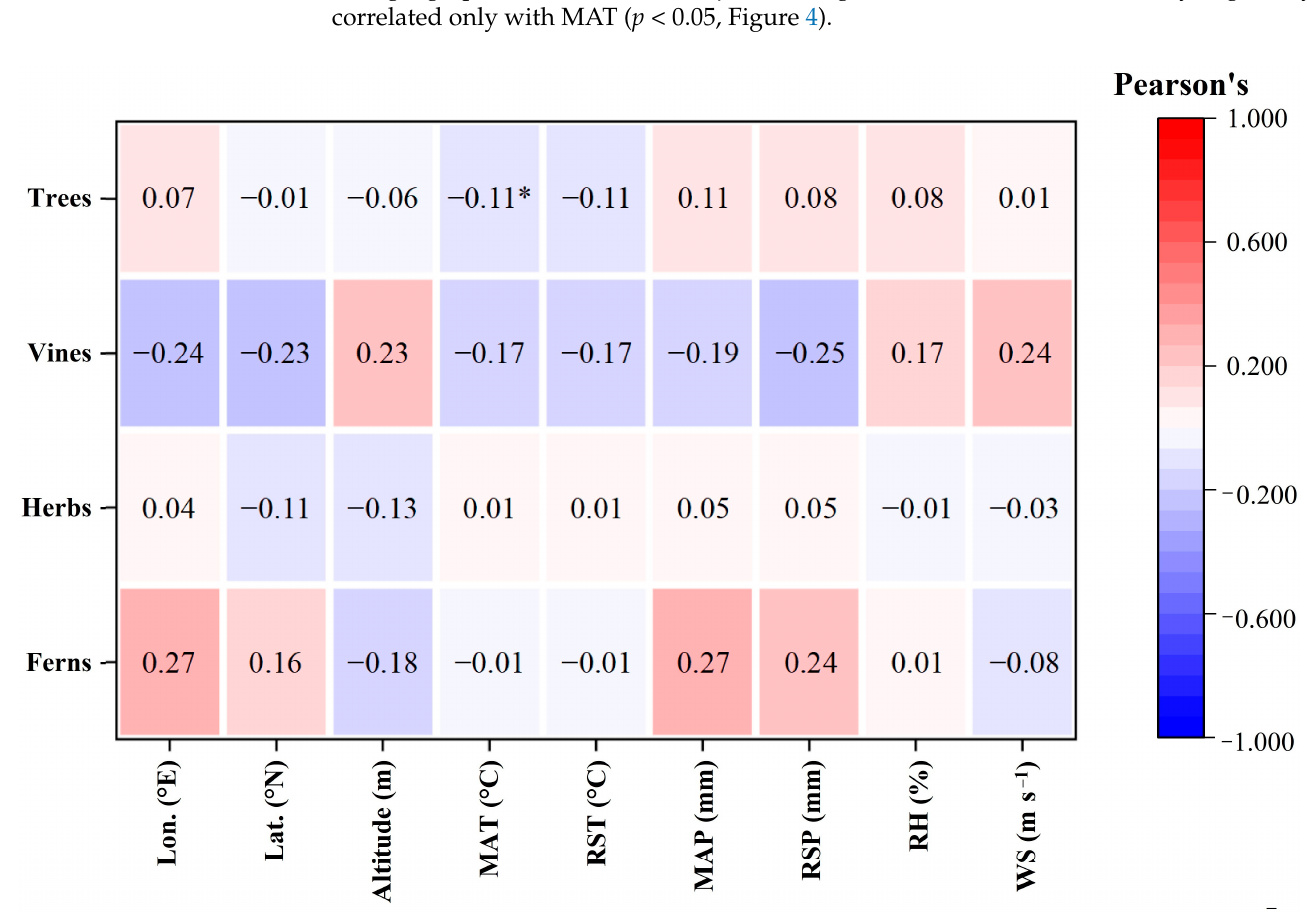
Figure 4. Pearson correlation coefficient of LCC in different plant functional types. * indicates significant correlations ( p < 0.05). The color in the figure represents the correlation coefficient, with red indicating a positive correlation and blue indicating a negative correlation. Lon., longitude; Lat., latitude; MAT, mean annual temperature; RST, rainy season temperature; MAP, mean annual precipitation; RSP, rainy season precipitation; RH, relative humidity; WS, wind speed.